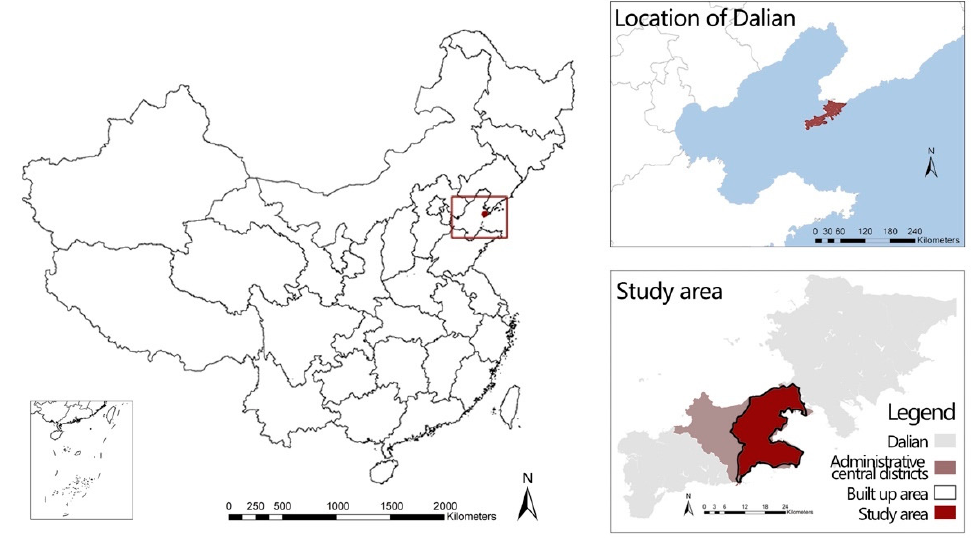
Figure 2. The location of Dalian and the studied area.